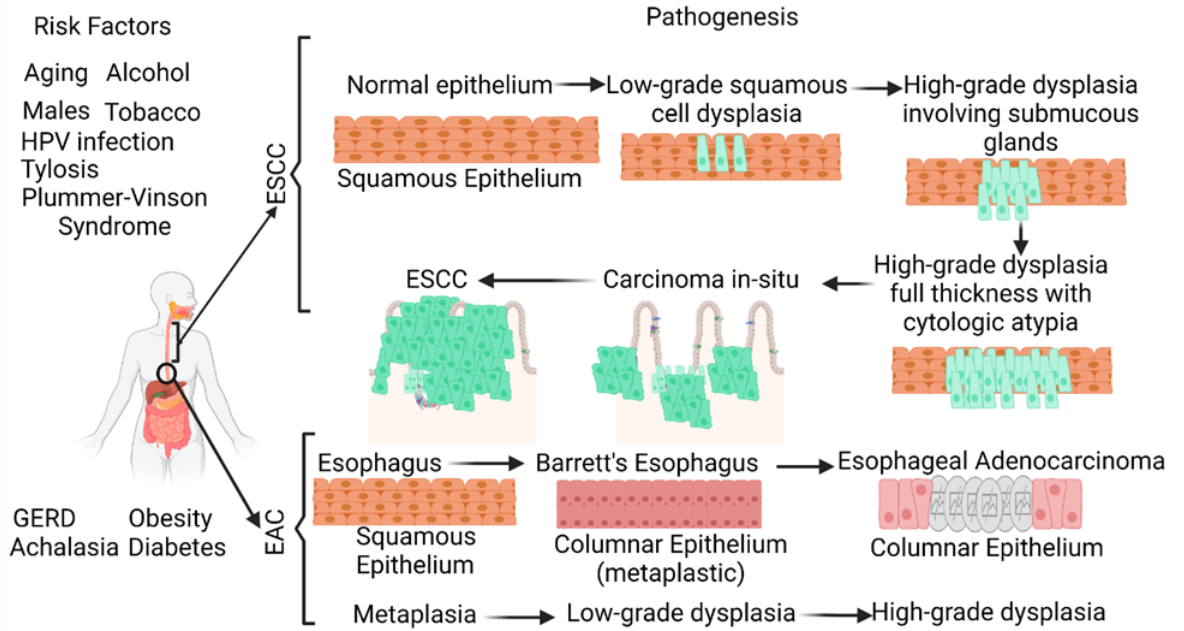
Figure 1. Schematic diagram showing the risk factors and pathogenesis of esophageal adenocarci- noma (EAC) and esophageal squamous cell carcinoma (ESCC). ESCC develops through a multistep process from basal hyperplasia due to chronic esophagitis through increasing severity of dysplasia, while EAC develops through a cellular cascade involving gastroesophageal reflux disease (GERD) followed by Barrett’s esophagus leading to EAC. There are different risk factors in the pathogenesis of ESCC and EAC. HPV, human papillomavirus.